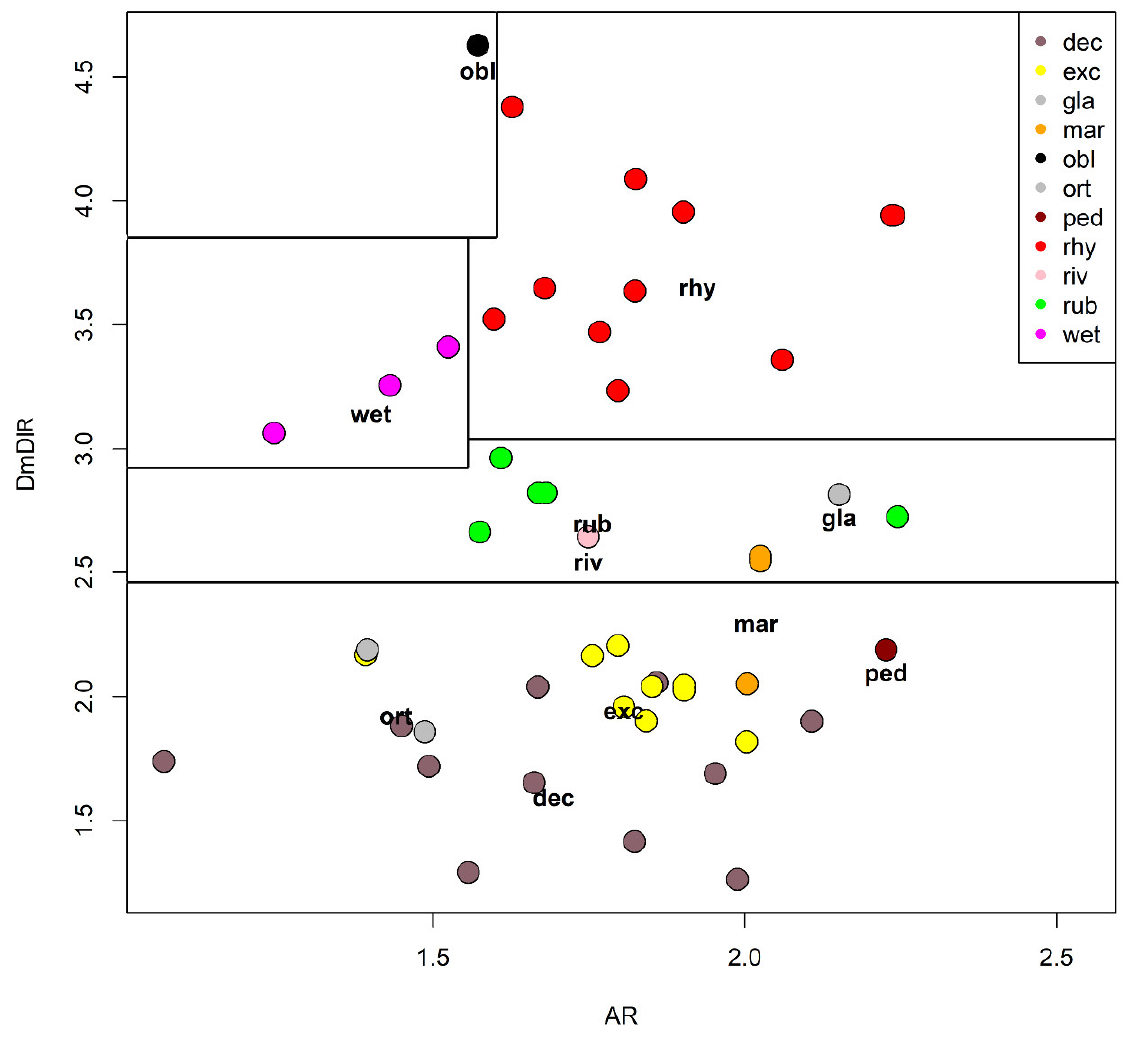
Figure 13. Plot of the ratio DmDl against the antennal ratio (AR). Dashed lines separates species with different morphometry, see Table 3 for abbreviations. Table 4. PCA analysis results, eigenvalues of the five axes and proportion of variance explained.